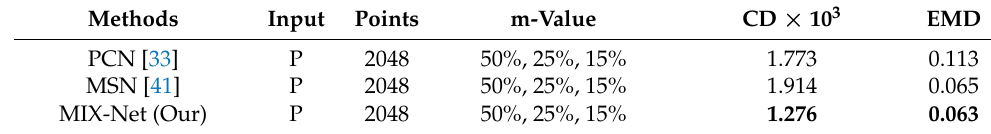
Figure 9. Supervised training results of MIX-Net on the point cloud leaf dataset. In the experiments, the predicted outputs of various methods after supervised training after missing 50%, 25%, and 15%. Table 5. The results on supervised learning of MIX-Net on seedling point cloud leaf